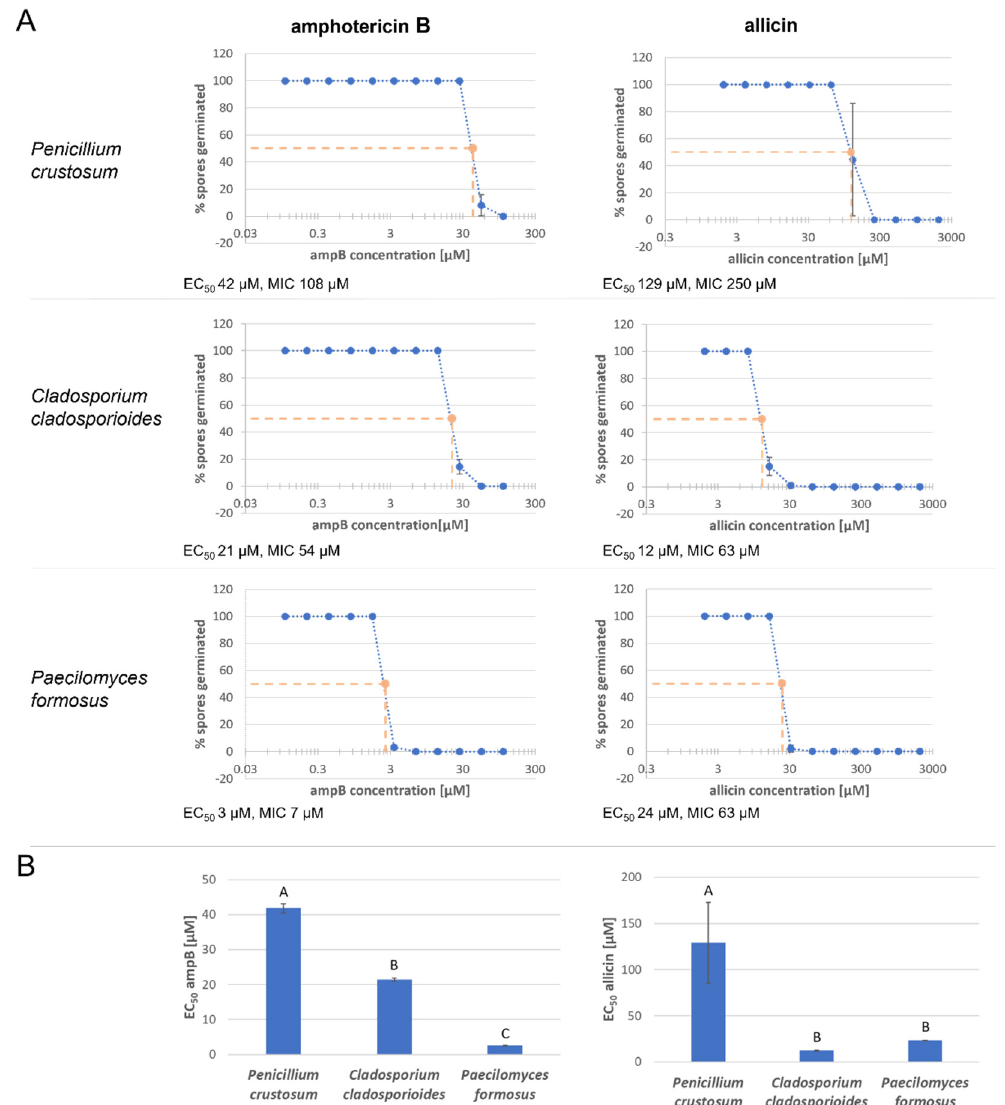
Figure 3. Allicin efficacy is comparable to that of amphotericin B. Fungal spore suspensions were mixed with sample solution. Spore germination was examined microscopically after 48 h of incu- bation. ( A ) Germinated and ungerminated spores were counted in an image field and the ratio of germinated spores to total spore number was calculated (diH 2 O or 3% DMSO was set to 100% spore germination). The mean values of three biological replicates with three technical replicates each are shown. Sample solution concentration was plotted logarithmically. Error bars represent the standard deviation. ( B ) n = 9, error bars show standard deviation. Same letter indicates no significant difference ( p > 0.05) in a One-Way RM ANOVA using the Holm–Šidák method.